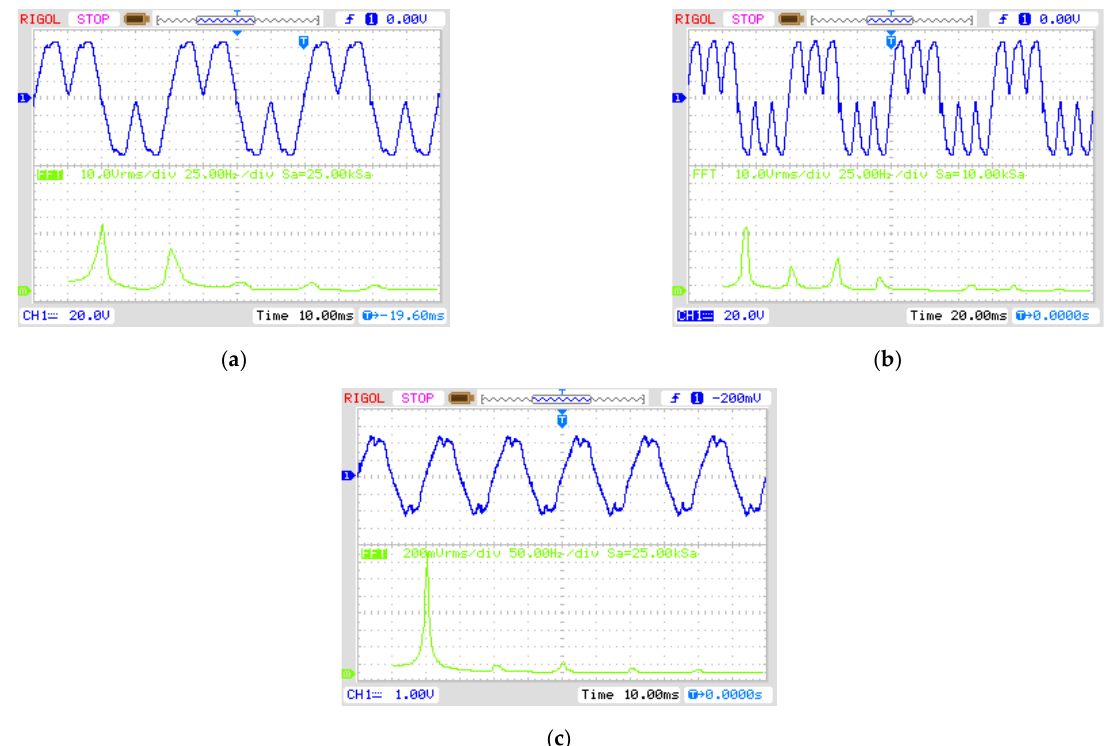
Figure 17. Practically recorded results without pulse voltage regulation capabilities: ( a ) output voltage and its FFT spectrum for one half output frequency; ( b ) output voltage and its FFT spectrum for one-third output frequency; ( c ) input current and its FFT spectrum.